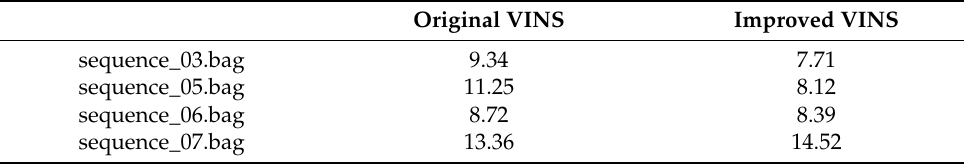
Table 8. The feature extraction speed of the original algorithm is compared with that of the improved algorithm in the underwater dataset. (Unit: ms).